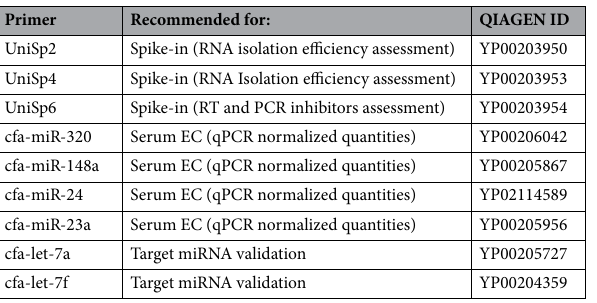
Table 1. List of primers used in qPCR. The resuspended primer mix contains a forward and reverse recognition sequence. The table reported Spike-in primers, serum EC, and differential target miRNA selected by